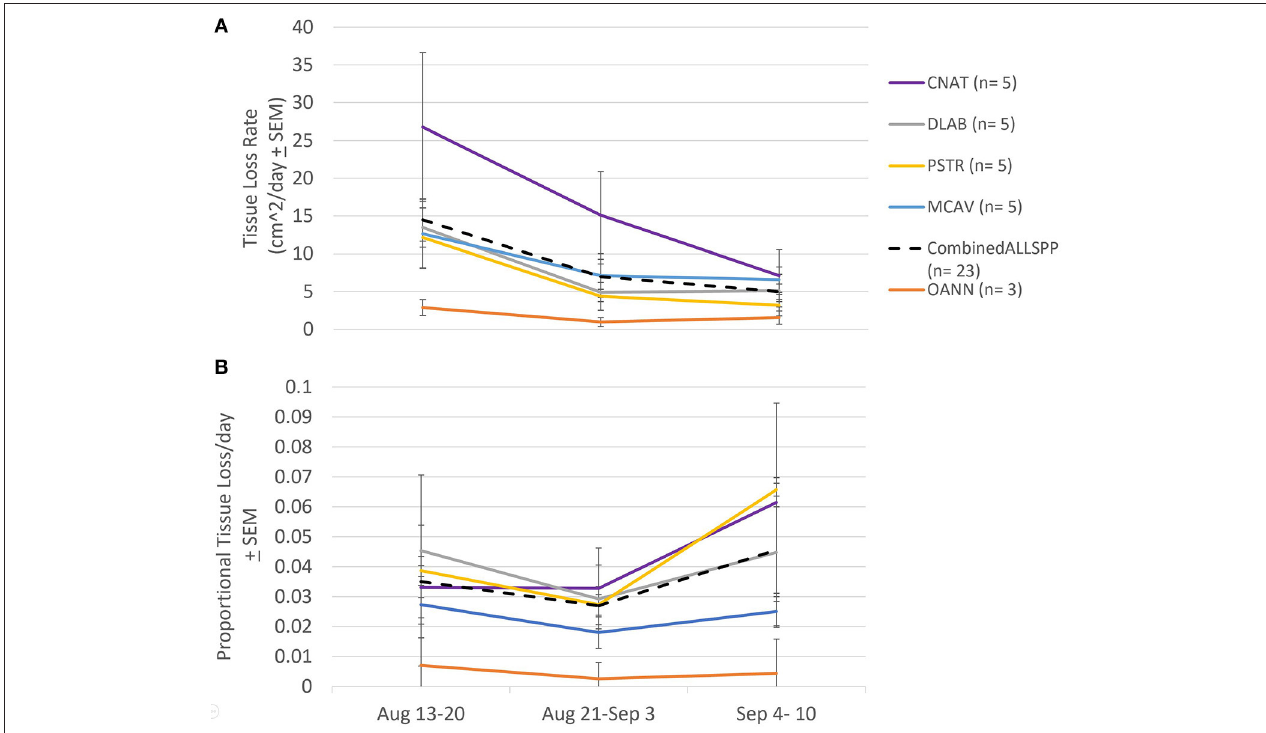
FIGURE 6 | Species specific tissue loss rates pre-bleaching. (A) Average tissue loss rates ( ± standard error) among species calculated for three time frames prior to the bleaching event. No difference in tissue loss rate between species, but a significant decline in rate over the month prior to the bleaching event. CNAT, Colpophyllia natans ; DLAB, Diploria labyrinthiformis ; MCAV, Montastraea cavernosa ; PSTR, Pseudodiploria strigosa ; OANN, Orbicella annularis ; Combined: average of all species combined. (B) Average proportional tissue loss rates ( ± standard error). No difference in tissue loss rate between species nor over time over the month prior to the bleaching